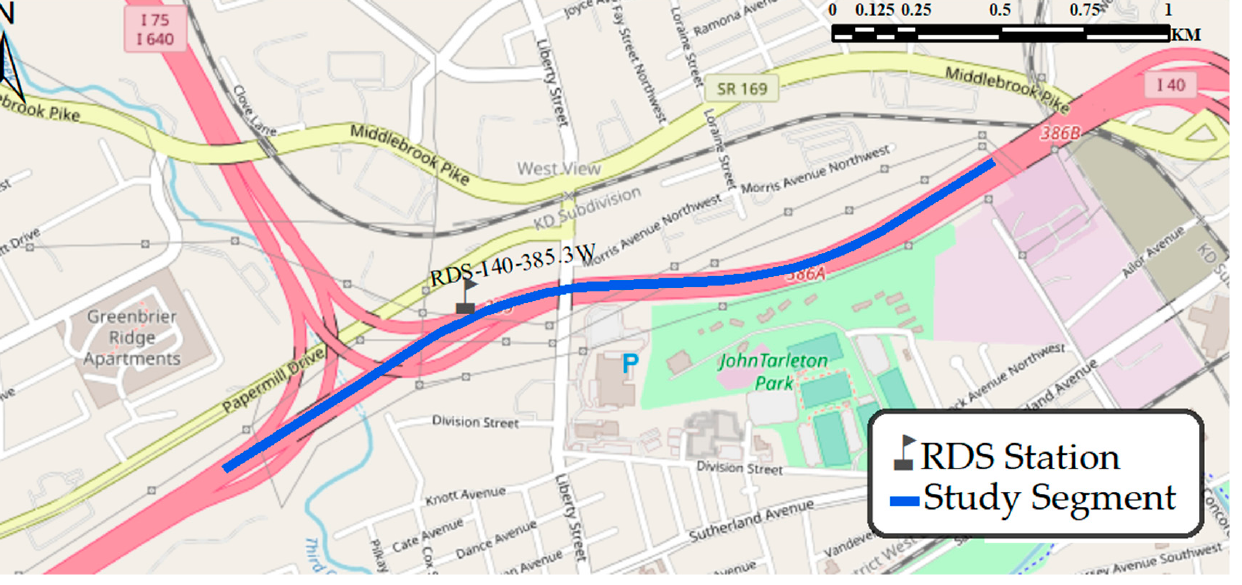
Figure 1. Framework of the proposed methodology. One month of data, representing 1 October 2019 to 31 October 2019 (744 h),